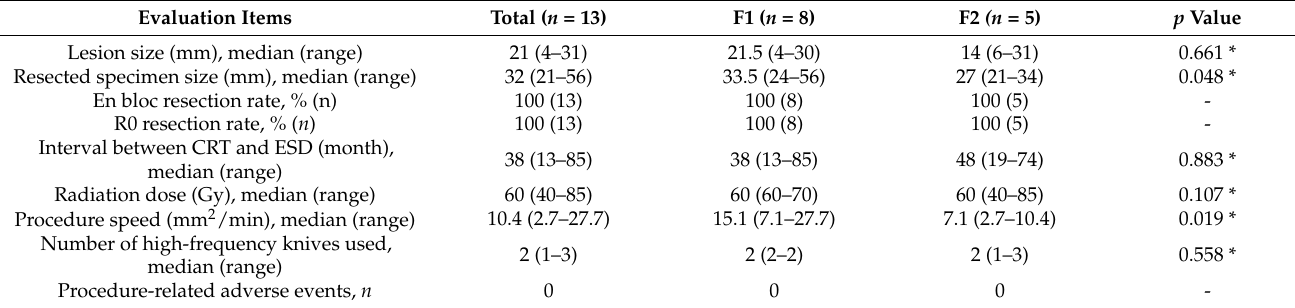
Table 2. Relationship between ESD results and Fibrosis scores.